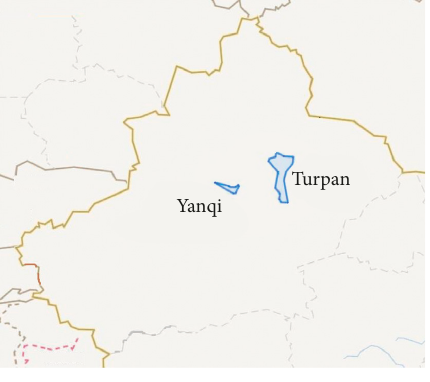
Figure 8: Location of Yanqi and Turpan. Table 3: Duration of sunshine on the representative date.